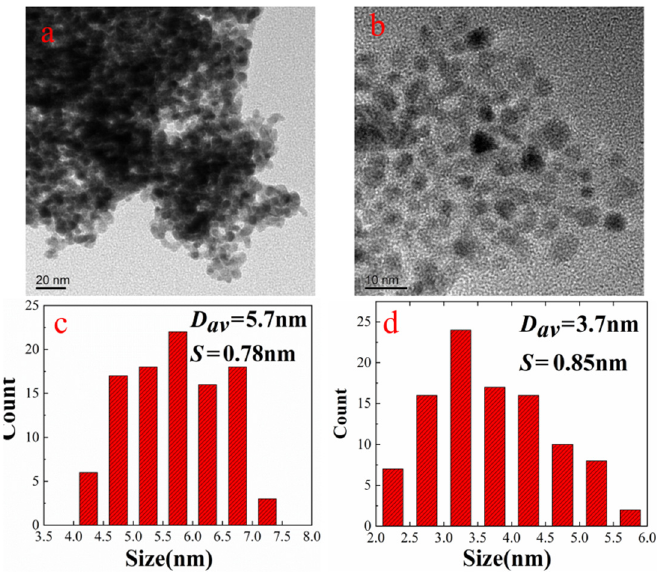
Figure 1. TEM images of nano-Pd ( a ) and nano-Fe/Pd ( b ) nanoparticles and corresponding particle size distribution ( c , d ).